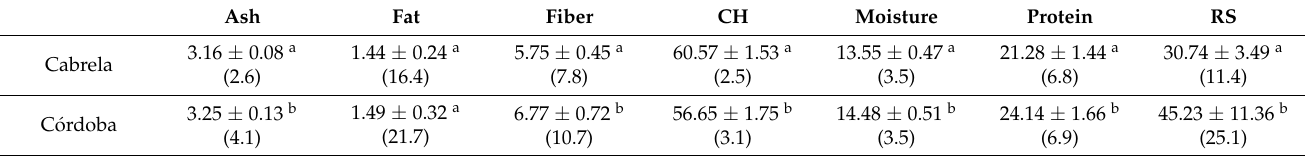
Table 1. Average ± standard deviation (and coefficient of variation (%)) of ash, fat, fiber, carbo- hydrates (CH), protein, moisture, and resistant starch (RS) contents (g/100 g) in a collection of 106 Portuguese common bean accessions grown in two contrasting environments (Cabrela with a mild climate, and C ó rdoba, a heat stress prone region). Data calculated from best linear unbiased estimators (BLUEs). In each column different letters indicate significant differences ( p < 0.05).